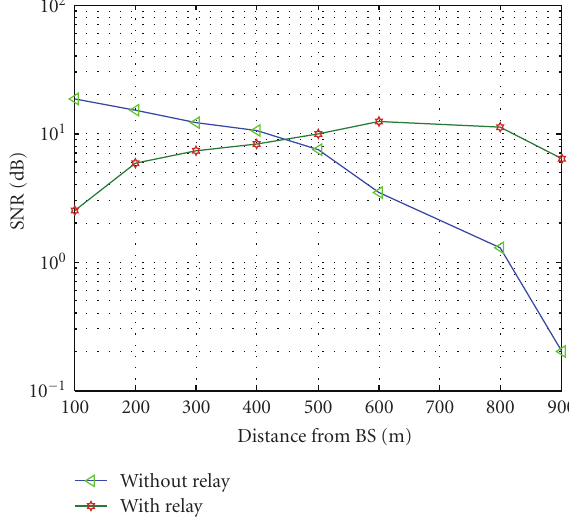
Figure 14: Outage probability of system.